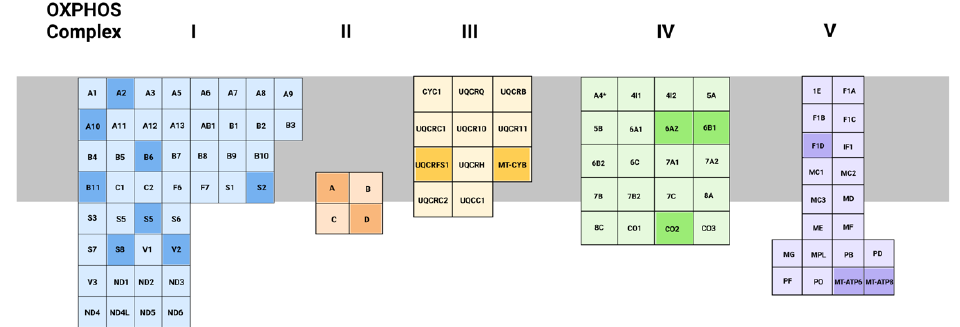
Figure 3. Illustration of the oxidative phosphorylation complexes and their respective subunits. Subunits are listed in alphabetical order in each complex and as such, complex prefixes have been left off. For example, in complex I, prefix NDU-; complex II SDH-; etc. Subunits shaded darker are reflective of genes with mutations curated from Origin of Mendelian Inheritance in Man (OMIM) by performing a search for “mitochondrial cardiomyopathy” on 4 January 2020. Table 1 : nDNA and mtDNA mutations resulting in mitochondrial cardiomyopathies.